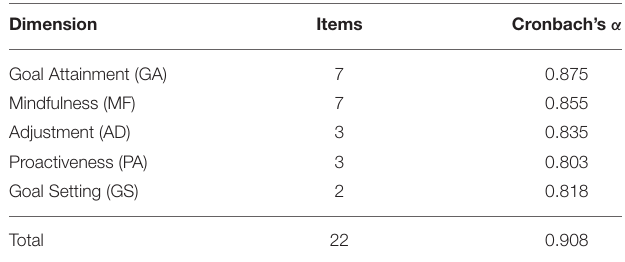
TABLE 5 | Dimensions, numbers of items, and internal consistency of the revised SSRQ. Dimension